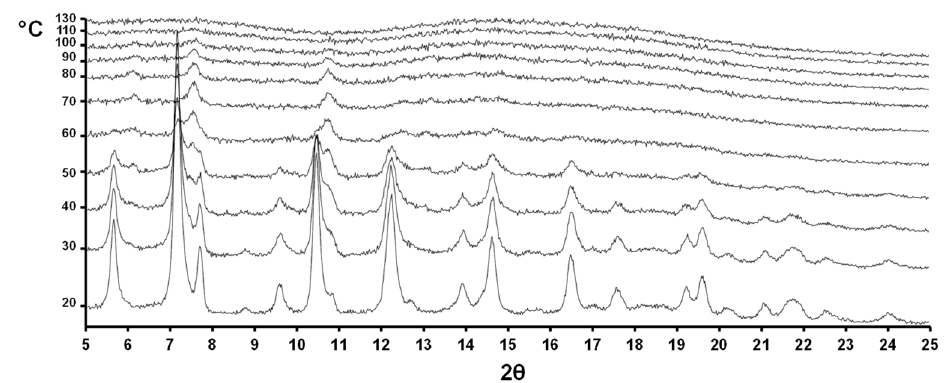
Figure 9. Two-dimensional contour plot as a function of 2 θ and temperature for the collection of PXRD patterns measured at elevating temperatures in the range of 25–130 °C for Moxi · 1.5MeNO 2 . The collection of PXRD patterns shows that the sample loses crystallinity at about 50 °C and becomes amorphous by raising the temperature. No peak shifts are observed. As a sign of amorphization, the lowering of peak intensities, starting from 50 °C, is observed. The sample can be considered fully amorphous at about 100 °C.